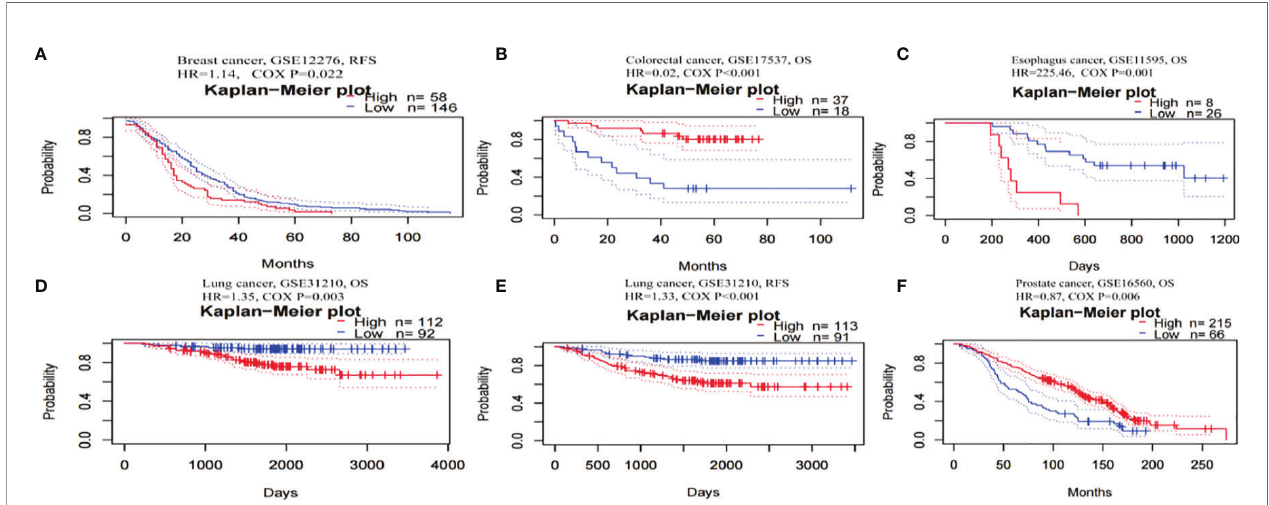
FIGURE 5 | Kaplan-Meier survival curves for patients with high or low TRPM8 levels, from PrognoScan. (A) RFS (n = 204) in breast cancer cohort GSE12276. (B) OS (n = 55) in colorectal cancer cohort GSE17537. (C) OS (n = 34) in esophagus cancer cohort GSE11595. (D, E) OS (n = 204) and RFS (n = 204) in lung cancer cohort GSE31210. (F) OS (n = 281) in prostate cancer cohort GSE16560. DSS, disease-speci fi c survival; OS, overall survival; RFS, relapse-free ( Figure 11A ). The network constructed by GeneMANIA showed interaction with TCAF2 (TRPM8 channel associated factor 2) ( Figure 11B ), which is involved in the regulation of TRPM8